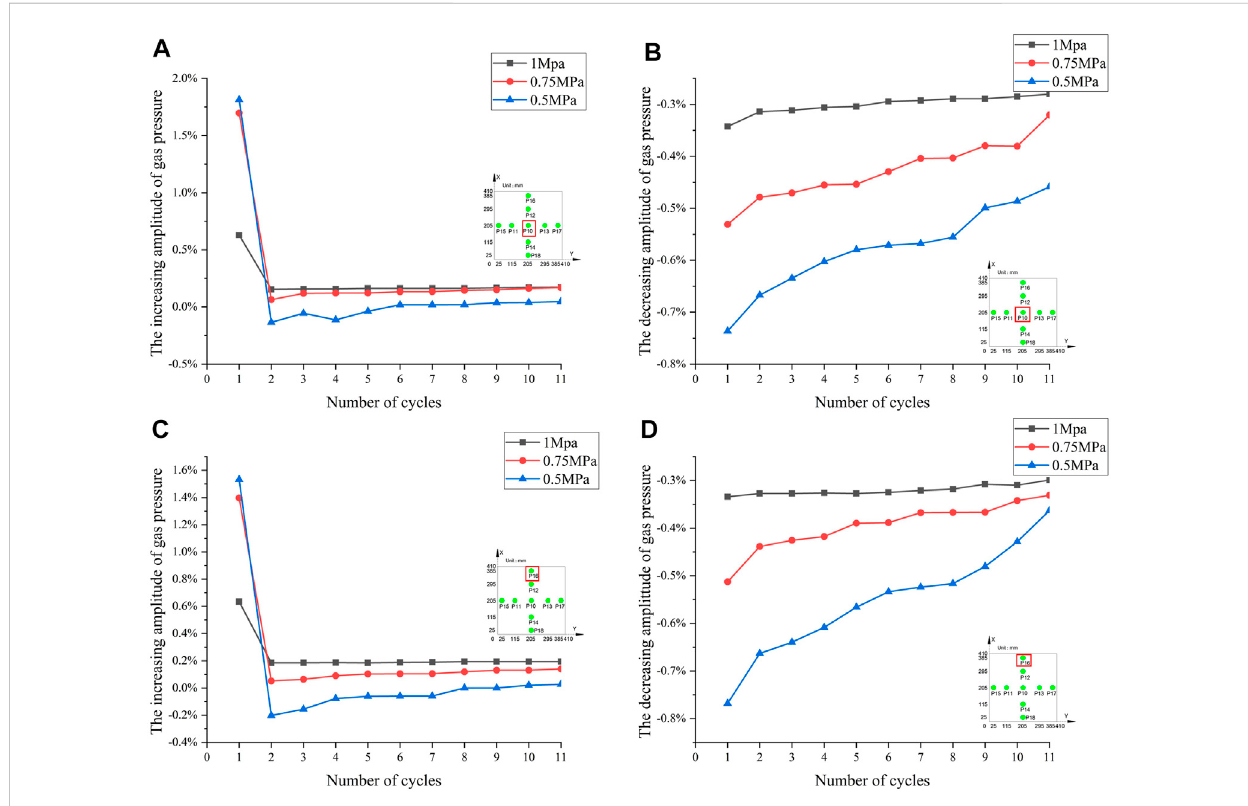
FIGURE 10 The changing law of gas pressure under different initial